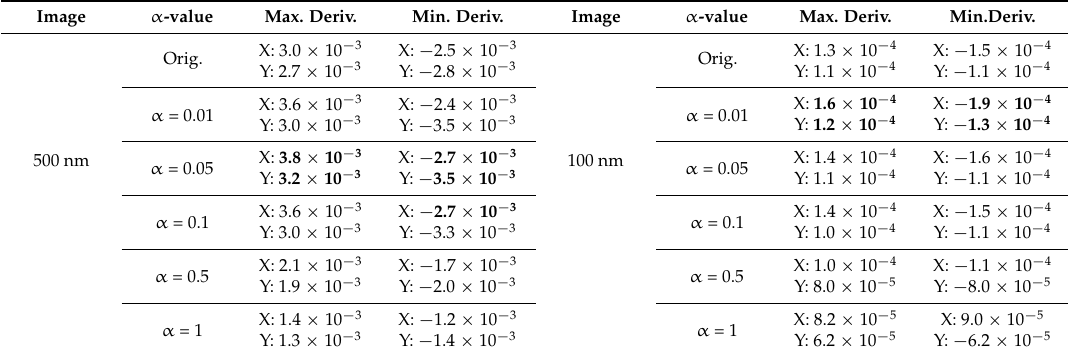
Table 2. Average value of full width at half maximum (FWHM) obtained from the derivatives of the intensity lines in Figure 8 (original image and α = 0.05 and α = 0.5) and the measurements across the